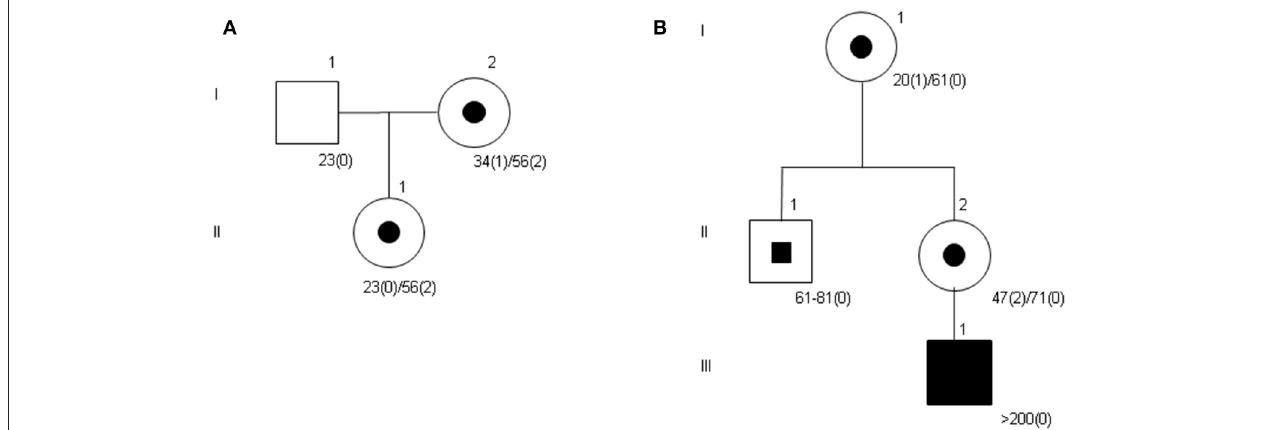
FIGURE 1 | Examples of pedigrees of studied families showing the expansion of the CGG repeats. (A) The allele with 56 CGG repeats and two AGG interruptions is inherited by the daughter without expansion. (B) In the third generation, the patient presents with Fragile X Syndrome with an allele of more than 200 repeats. Subject II-1 presents a mosaicism in the number of CGG repeats.